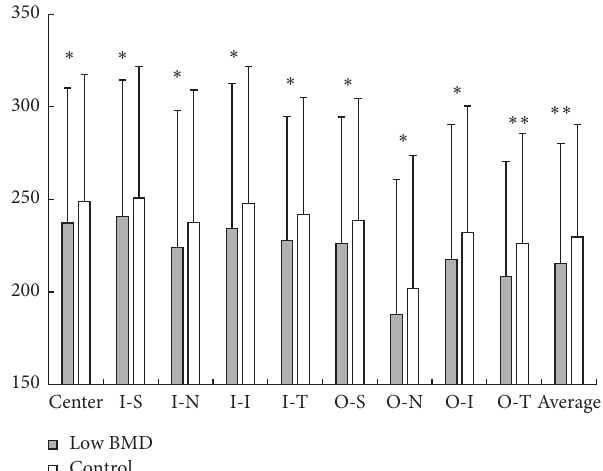
Figure 2: The choroidal thickness of nine sectors of the ETDRS grid in the low BMD compared with the controls. I-S: inner superior; I-N: inner nasal; I-I: inner inferior; I-T: inner temporal; O-S: outer superior; O-N: outer nasal; O-I: outer inferior; O-T: outer